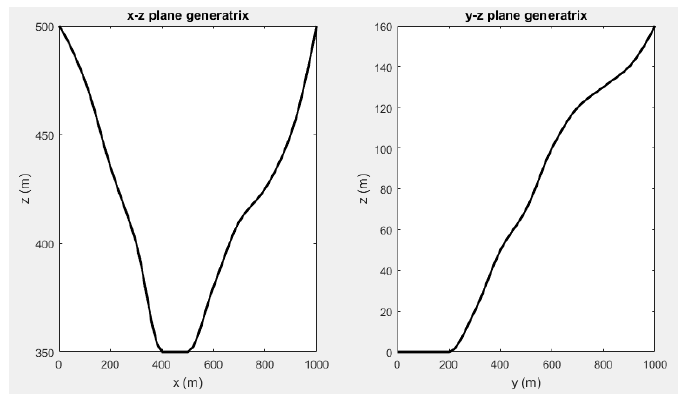
Figure 1. Base surface elevation profiles expressed in terms of x - z and y - z plane generatrix.